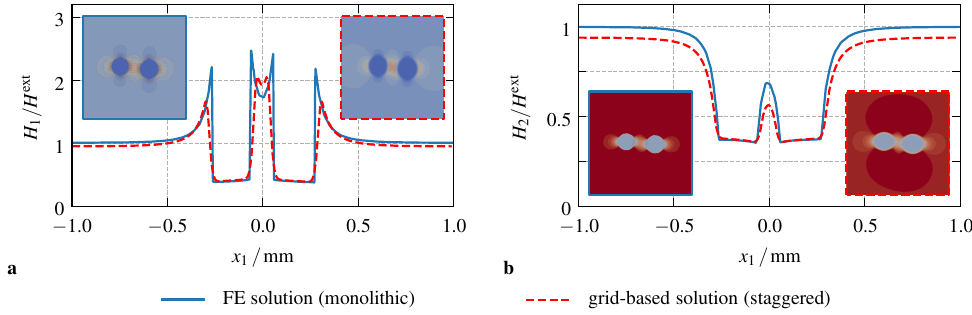
Figure 4. Plot of the normalized magnetic field along the x 1 -axis of the sample: ( a ) results for α = 0°, and, ( b ) for α = 90°. The embedded surface plots show the distributions of the field within the whole sample using the same scale as indicated in the